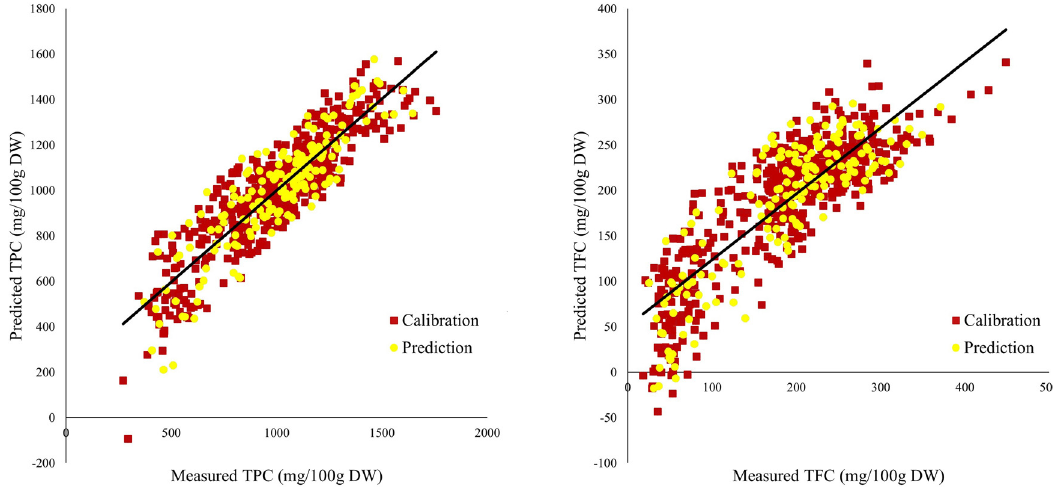
Figure 2: Scatter plot for calibration and prediction of total phenolic ( TPC ) and fl avonoid content ( TFC ) in horticultural products.